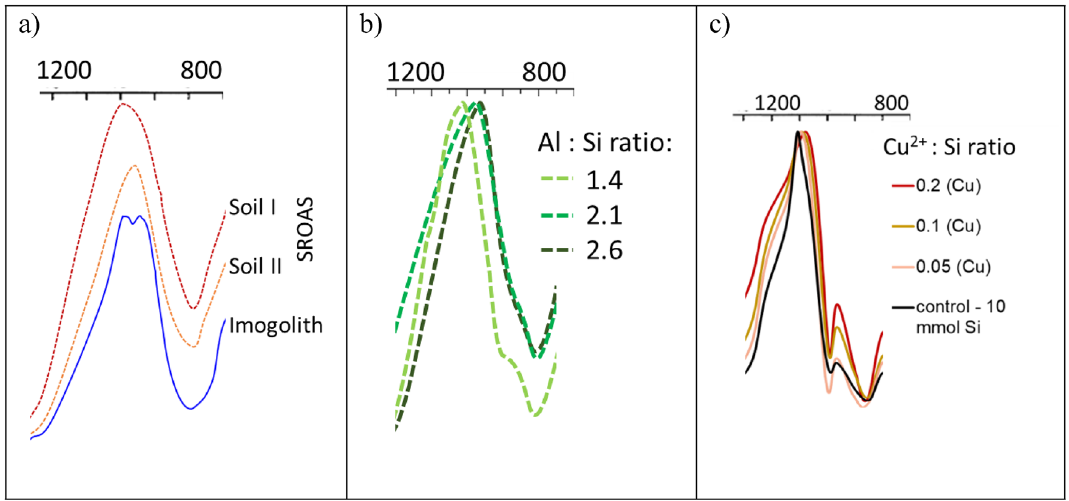
Figure 6. WN 800–1200 cm −1 sections in FTIR spectra of ( a ) soil allophanes and imogolith (adopted from Wada et al. 1979), ( b ) short-range ordered aluminosilicates SROAS with different Al:Si ratios (adopted from Lenhardt et al. 20 ), and ( c ) polymerized silica associated with Cu 2+ (adopted from Stein et al. 19